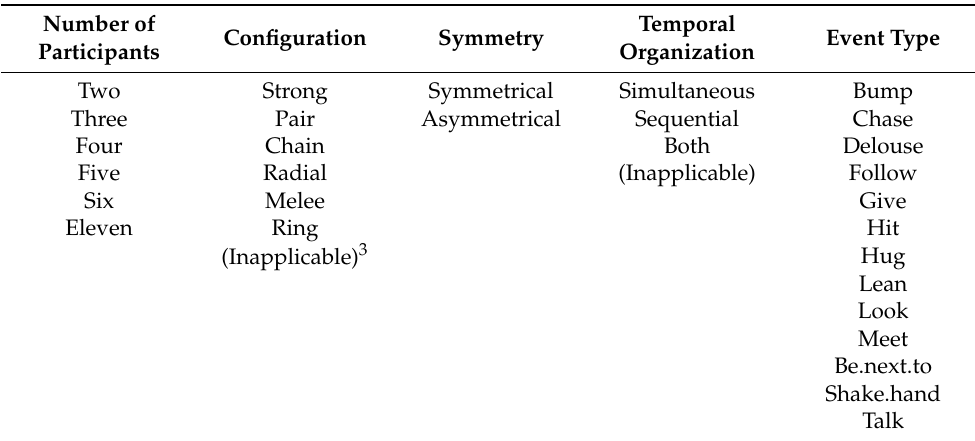
Table 4. Features manipulated in event types in video